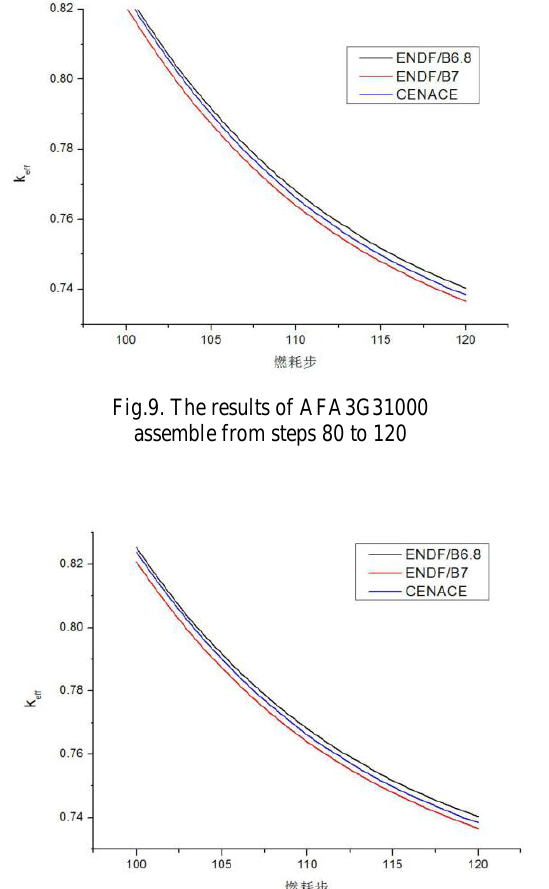
Fig.10. The results of AFA3G31016 assemble from steps 80 to